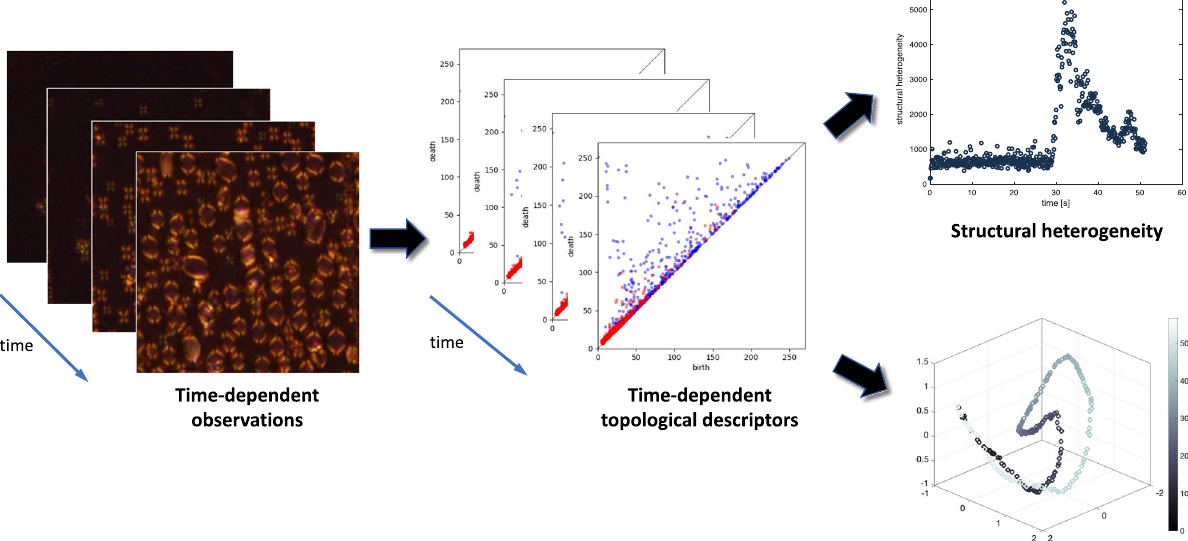
Fig. 7 Framework for the topological characterisation of soft matter systems. The evolution of the physical system is captured using time-dependent persistent homology, which is summarised through structural heterogeneity and the topological